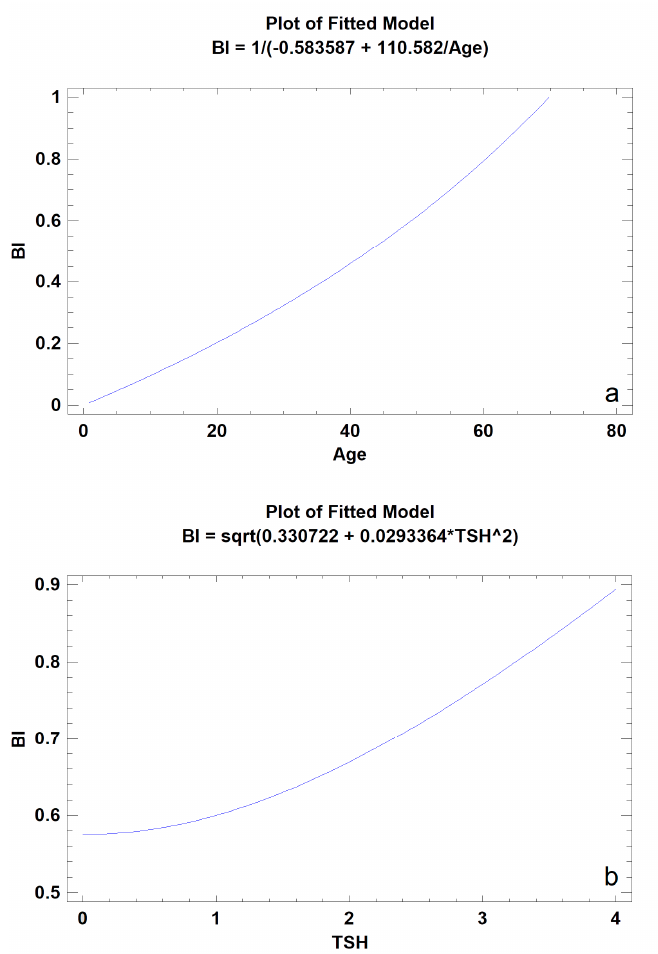
Figure 3. The models of simple regression describing the relationship of the 12-month bone regeneration outcome, expressed as BI calculated from intraoral radiographs, to patient ′ s age ( a ) and TSH level ( b ) ( p < 0.05).